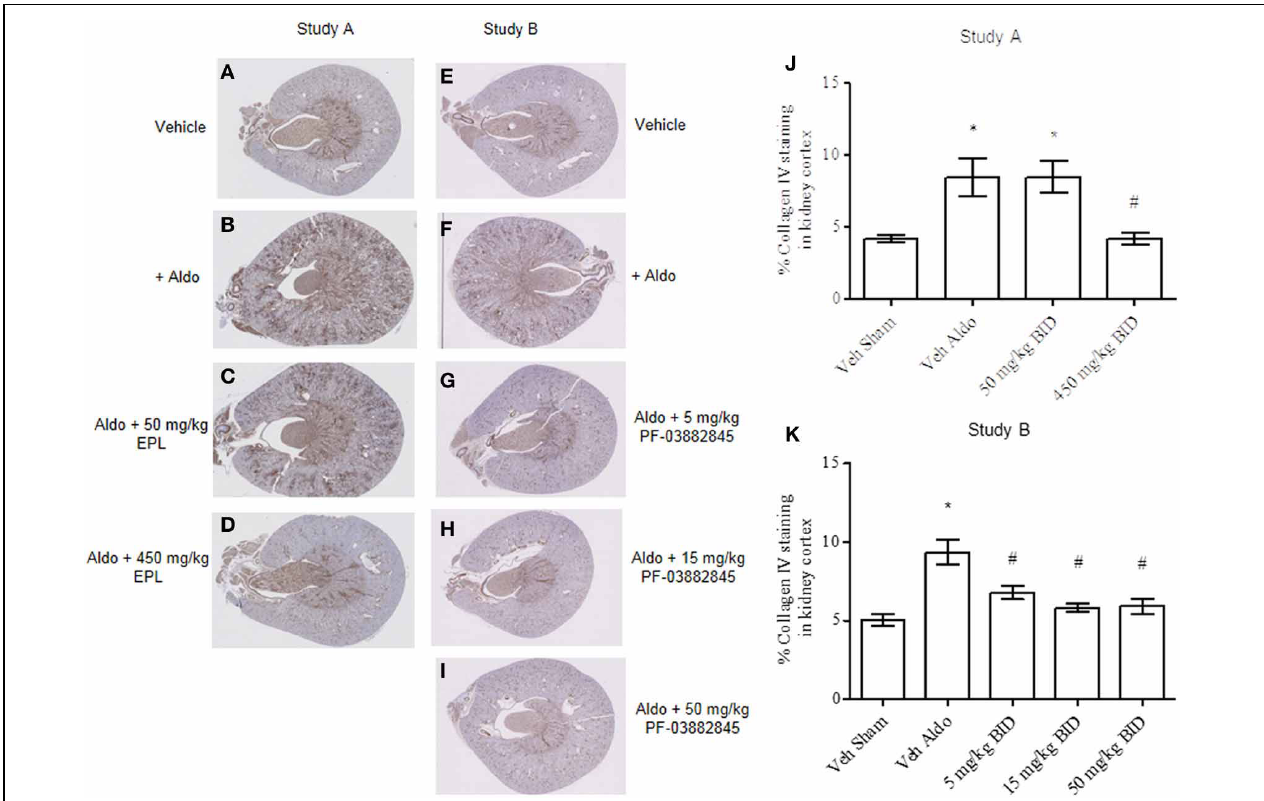
PF-03882845 (I) following 27 days of treatment. Data expressed as % collagen IV staining in kidney cortex and represented as mean ± standard error of the mean: Study A (J) and Study B (K) . See Materials and Methods for statistical analysis. ∗ Indicates a significant difference from the vehicle sham (Veh Sham) group; # Indicates a significant difference from the vehicle + aldosterone (Veh Aldo)